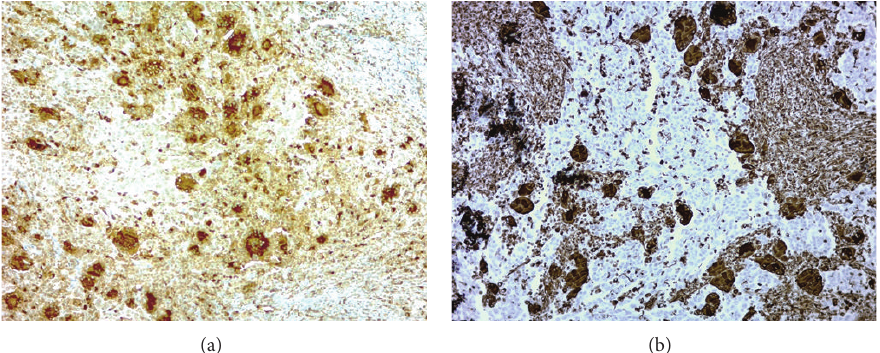
Figure 4: (a) Reactivity to CD68 in the giant cell population and lack of reactivity in the squamous component. Immunohistochemical stain with anti-CD68 antibody, × 50. (b) Reactivity to Vimentin in the giant cell population and lack of reactivity in the squamous component. Immunohistochemical stain with anti-Vimentin antibody, × 50.